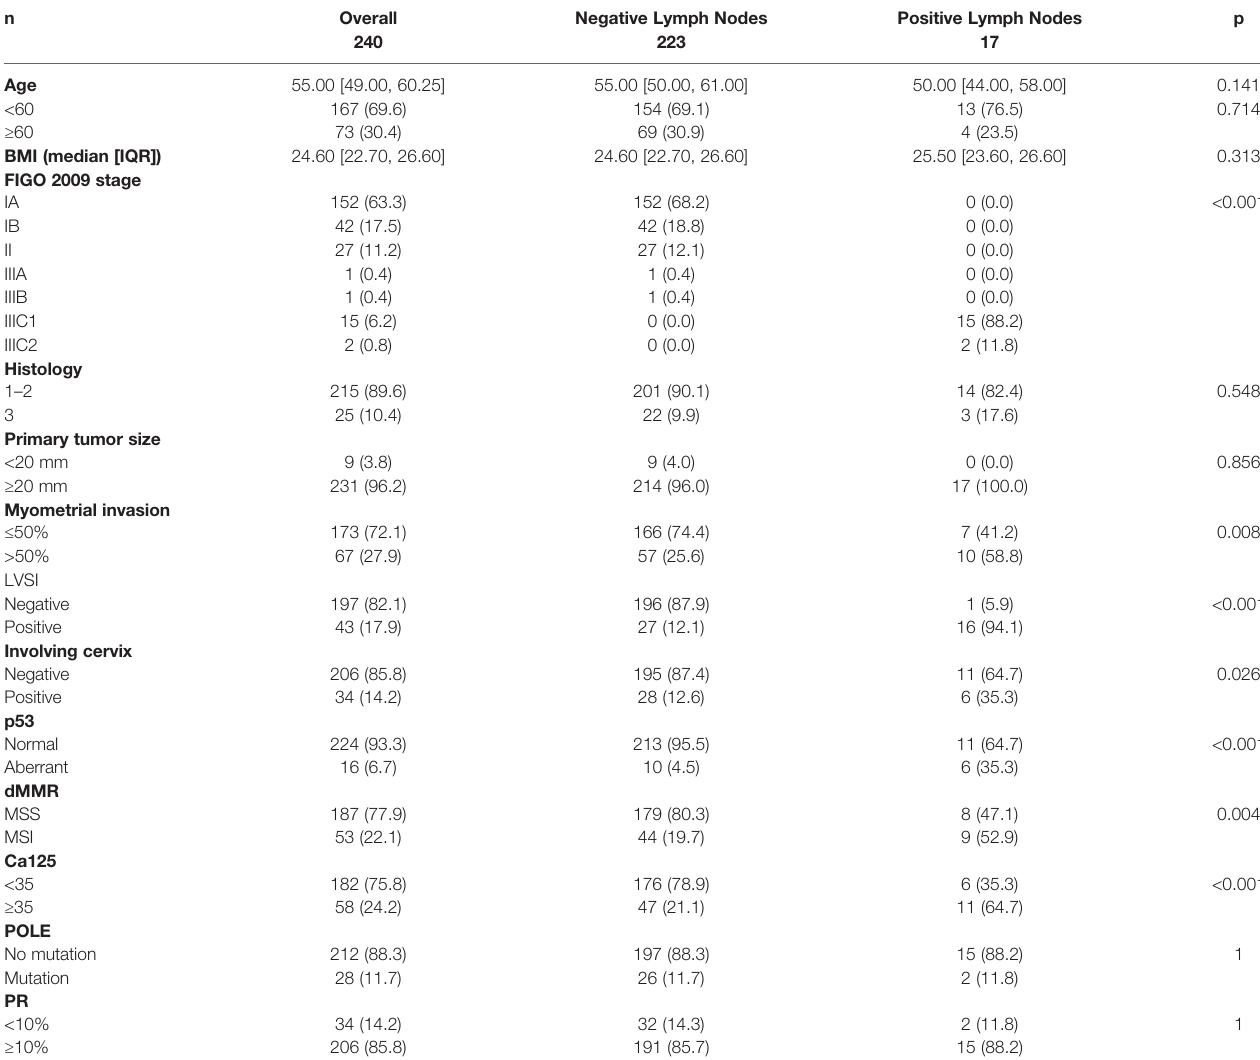
TABLE 1 | The demographics and pathological characteristics of the